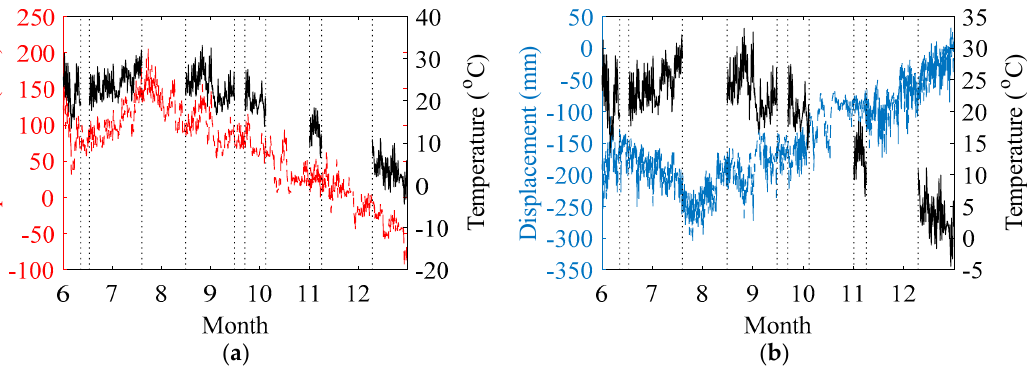
Figure 7. Trend of longitudinal displacements at the south girder end from June to December in 2017 (compared with the trend of atmospheric temperature): ( a ) bearing (B-7-11); ( b ) expansion joint (EJ-7-1).